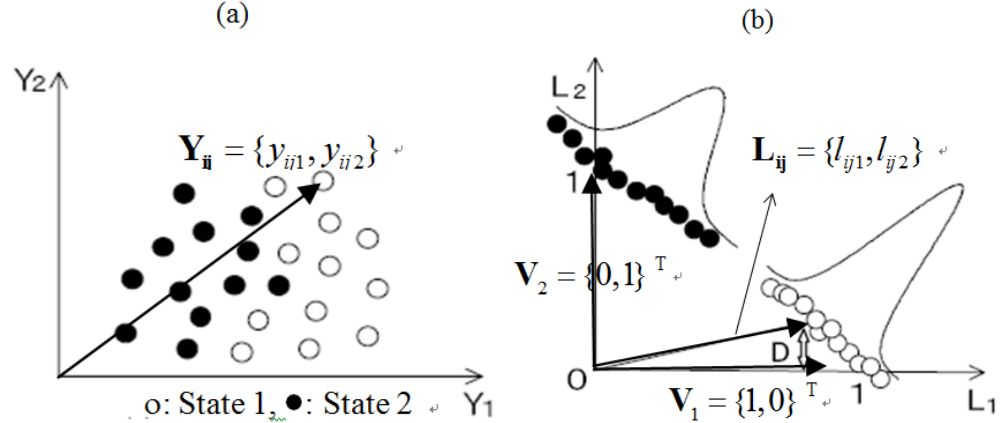
Figure 5. Projected example by the LSM ( a ) before projection; ( b ) after